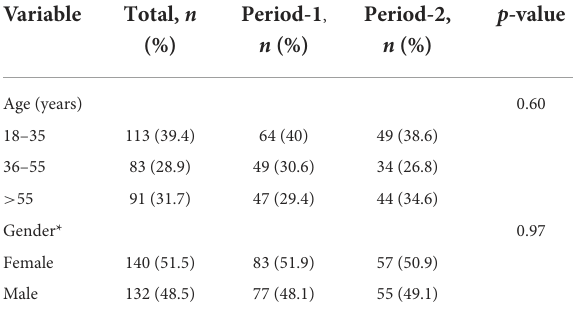
TABLE 1 Estimated incubation period for all confirmed COVID-19 cases.